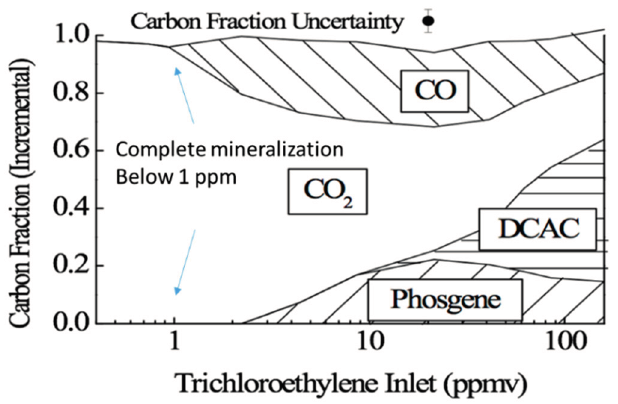
Figure 4. Measured PCO products vary with increasing concentration. Complete mineralization occurs at low concentrations. A different version of this diagram is shown in ref.